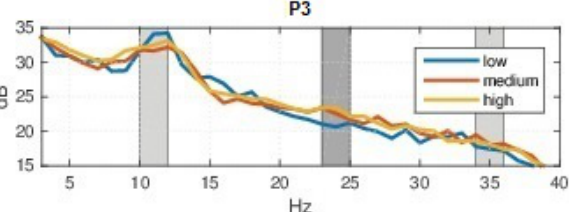
Figure 13. GA Spectrum for Frac images on three complexity levels according to participants subjective evaluation, at P3